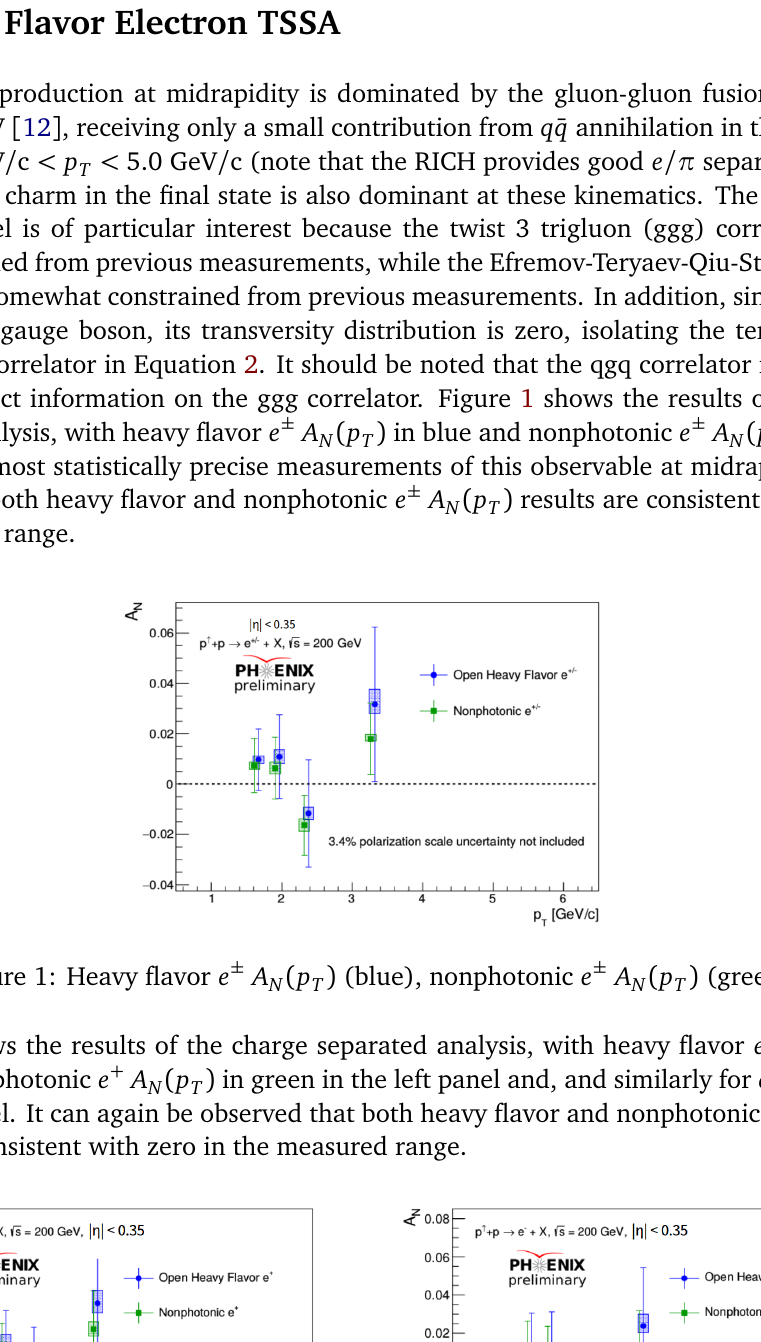
( p ) (green). N T ( p ) N T